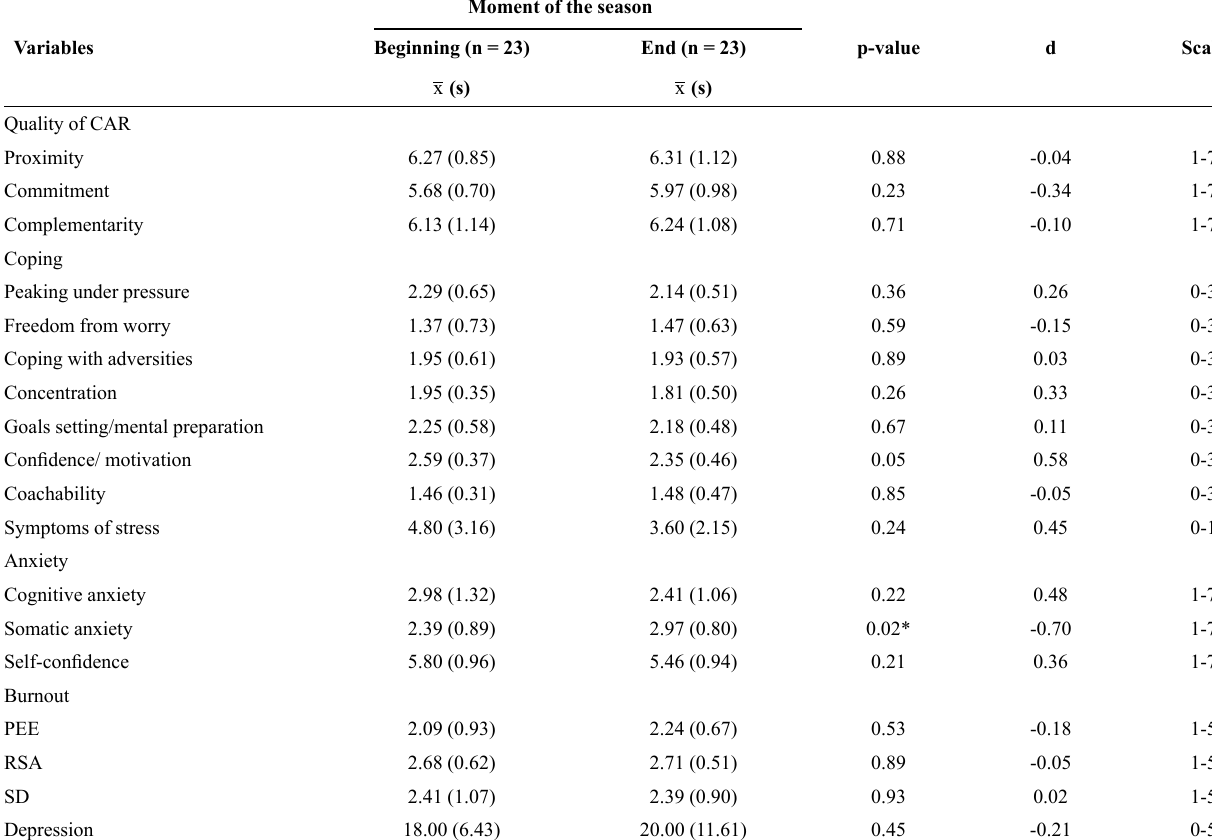
Table 1 - Comparison of CAR quality, coping, stress, anxiety, burnout and depression at the beginning and end of the season of youth soccer players. Moment of the